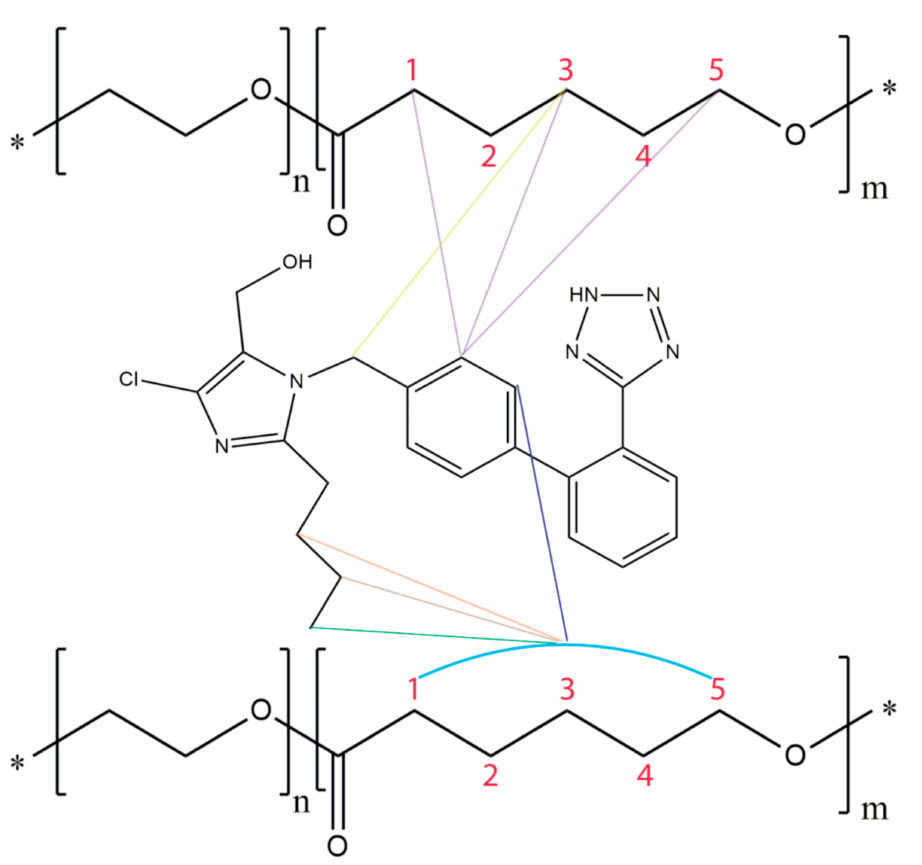
Figure 8. Eminent hydrophobic interactions when losartan approaches PEO-b-PCL micelles. The colorful lines represent the NOEs between losartan and the polymer. The “*” sign denotes the presence of end groups in the polymer